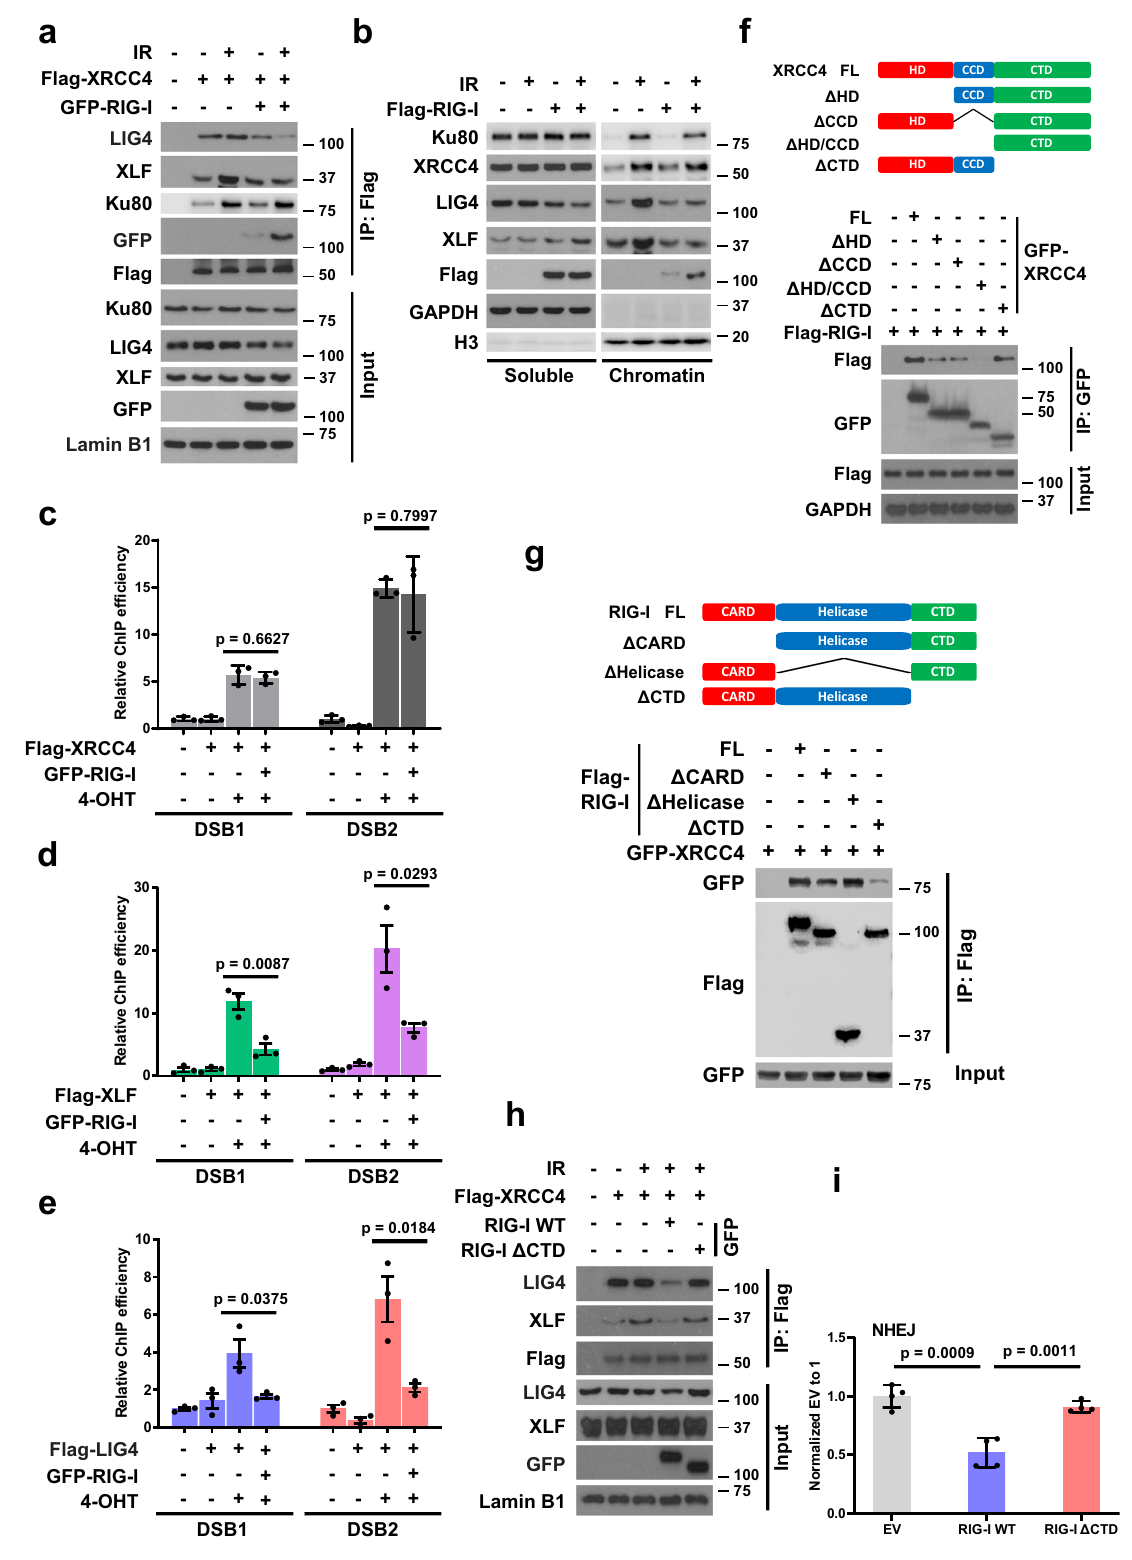
Fig. 4u, comparable GFP RNA levels were observed in 3p- hpRNA-treated and -untreated cells. In addition, neither RIG-I overexpression nor depletion had a signi fi cant effect on viral infection into host cells (Supplementary Fig. 4v, w), suggesting that it is the viral integration into host genome but not initial viral